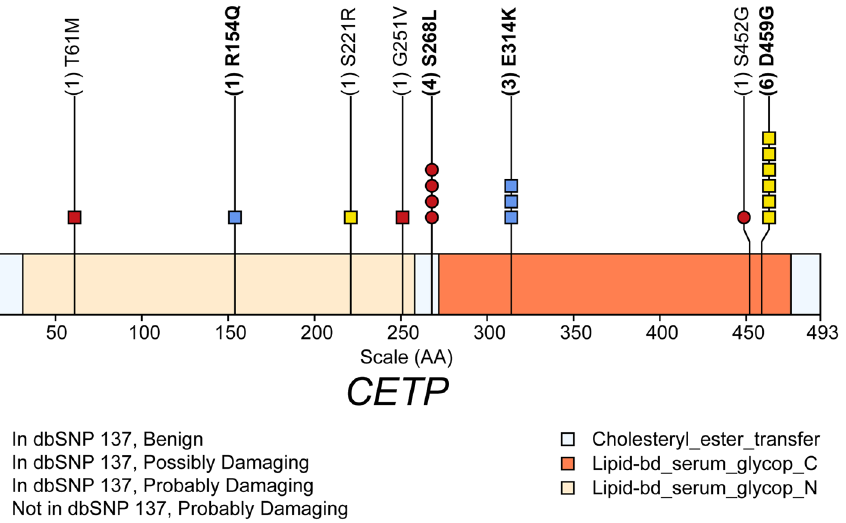
Figure 2. Schematic of rare (MAF , 1%) non-synonymous variants used in the gene-level test HDL-C in gene CETP . The x-axis scale (AA) is in amino acid positions. Numbers in parenthesis are the number of copies of the rare variant in persons with phenotype data. The mean HDL-C level in persons possessing variants with bold naming is increased relative to persons without the variant, for all other variants the mean HDL-C level in persons possessing variant alleles is decreased relative to persons without the variant.